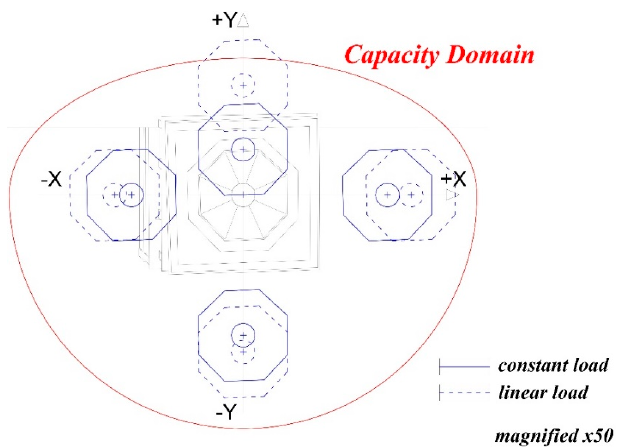
Figure 11. Capacity domain from pushover analysis.